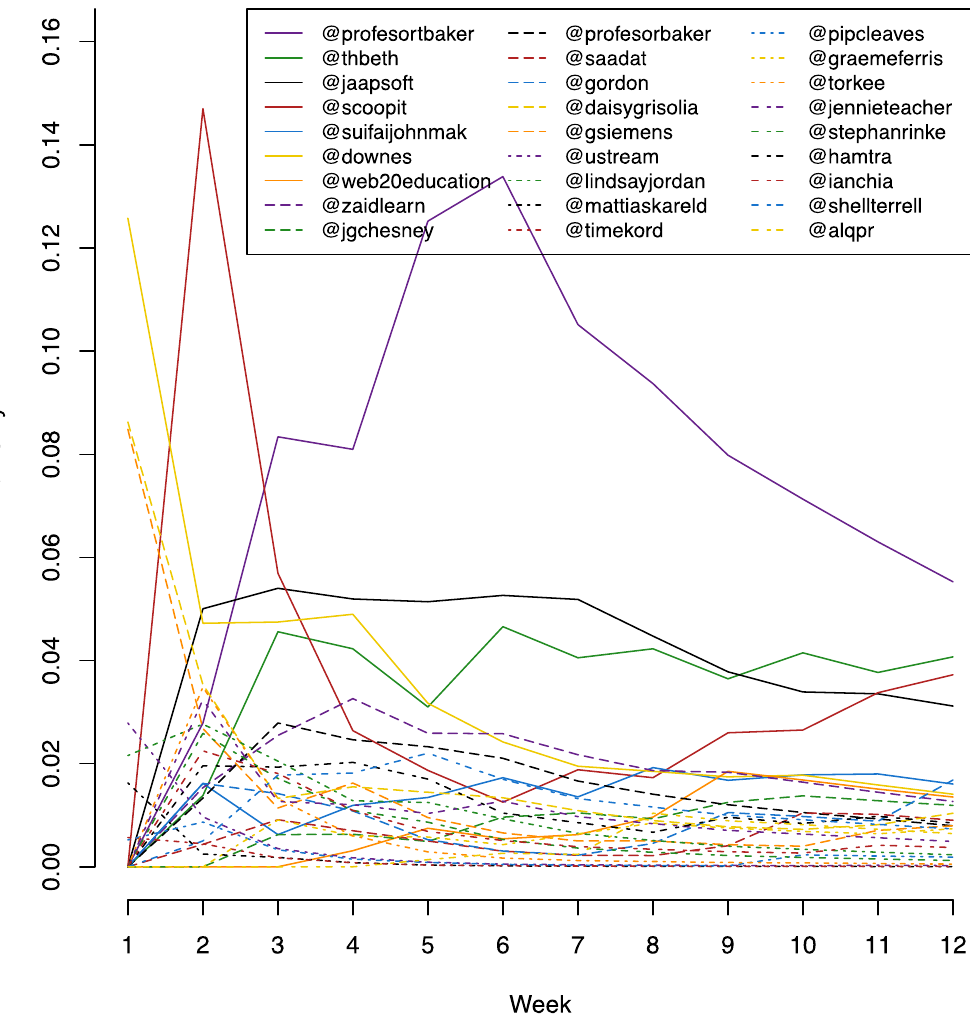
Figure 3. Variation of the authority weights for the top ranked social nodes, over the twelve weeks of the